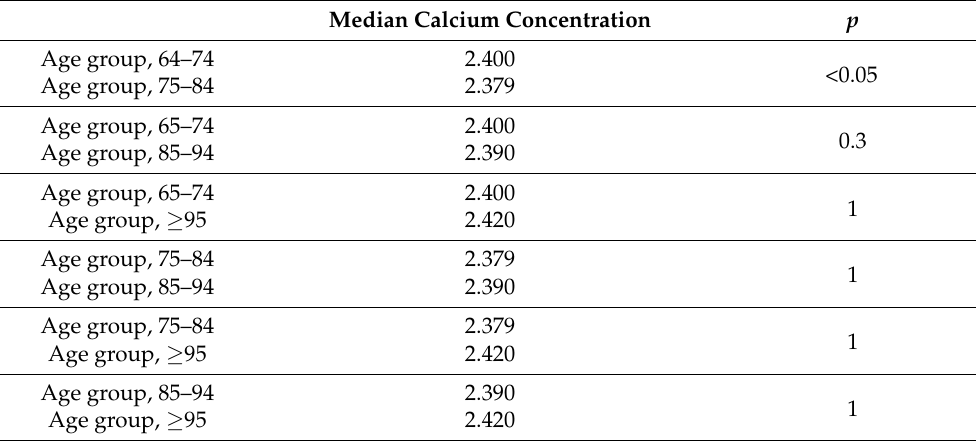
Table 3. Comparison of the median calcium concentrations between the age groups (Kruskal– Wallis